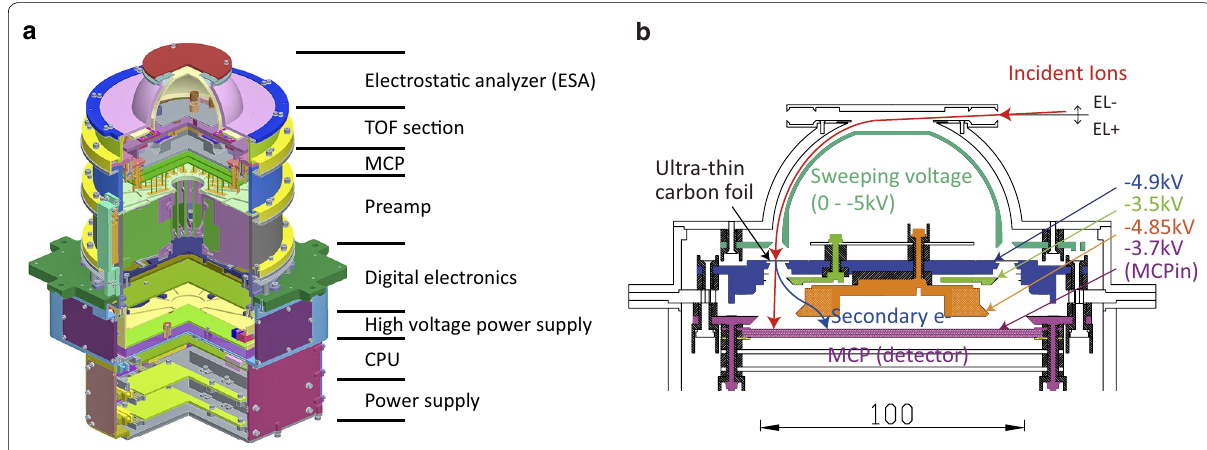
Fig. 3 Shape of LEPi. a 3D view with a partial cut. b Sectional view of the sensor